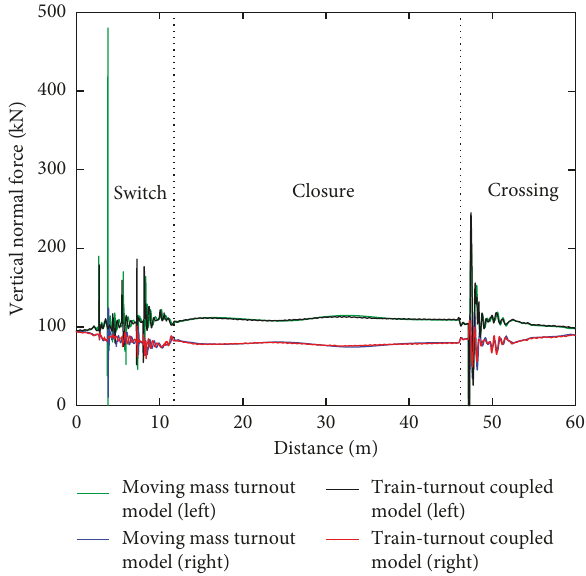
Figure 5: Schematic plan view of the turnout geometry.